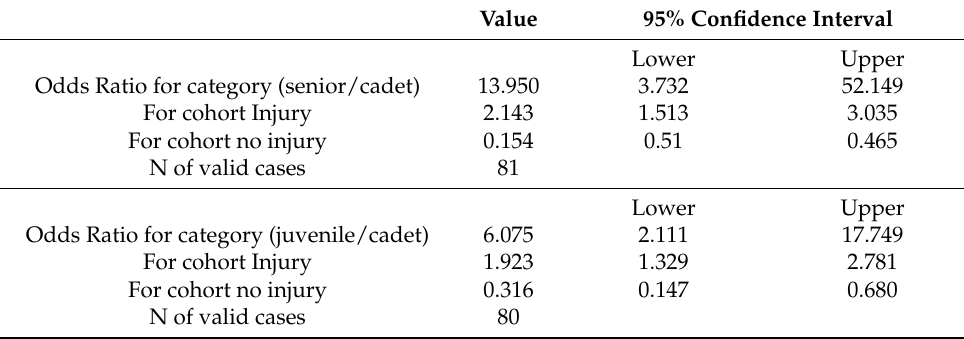
Table 5. Risk ratio of the relationship between category of female handball players (senior vs. cadet/juvenile vs. cadet) and risk of injury.